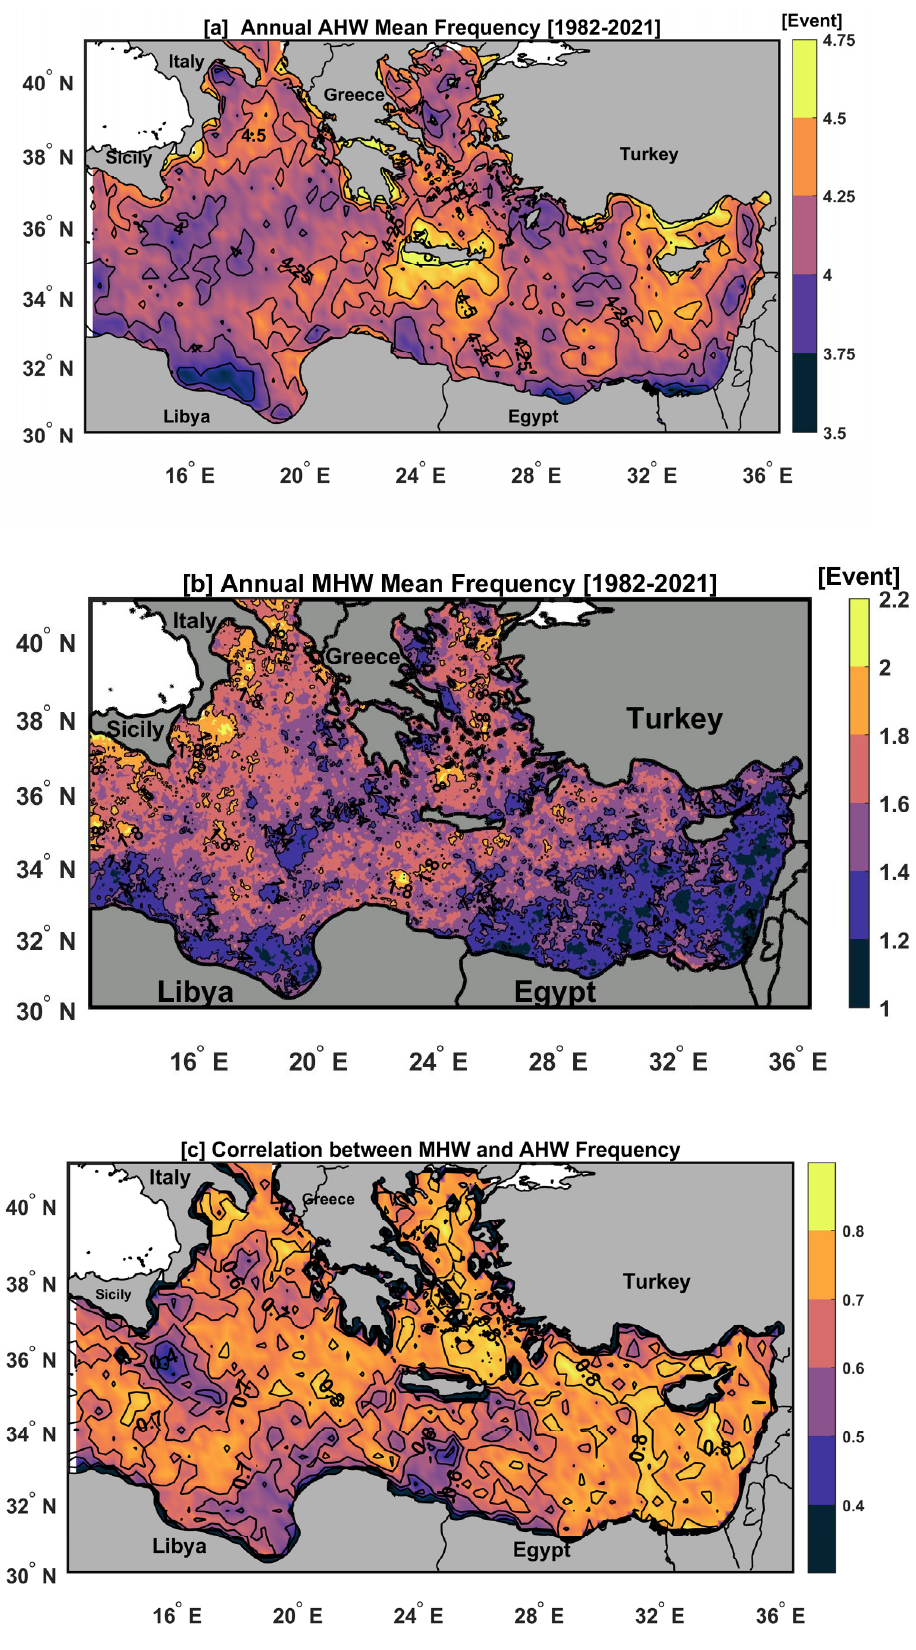
Figure 4. The spatial distribution of the annual mean of ( a ) AHW frequency (events), ( b ) MHW frequency (events), and ( c ) the correlation map between them from 1982 to 2021.